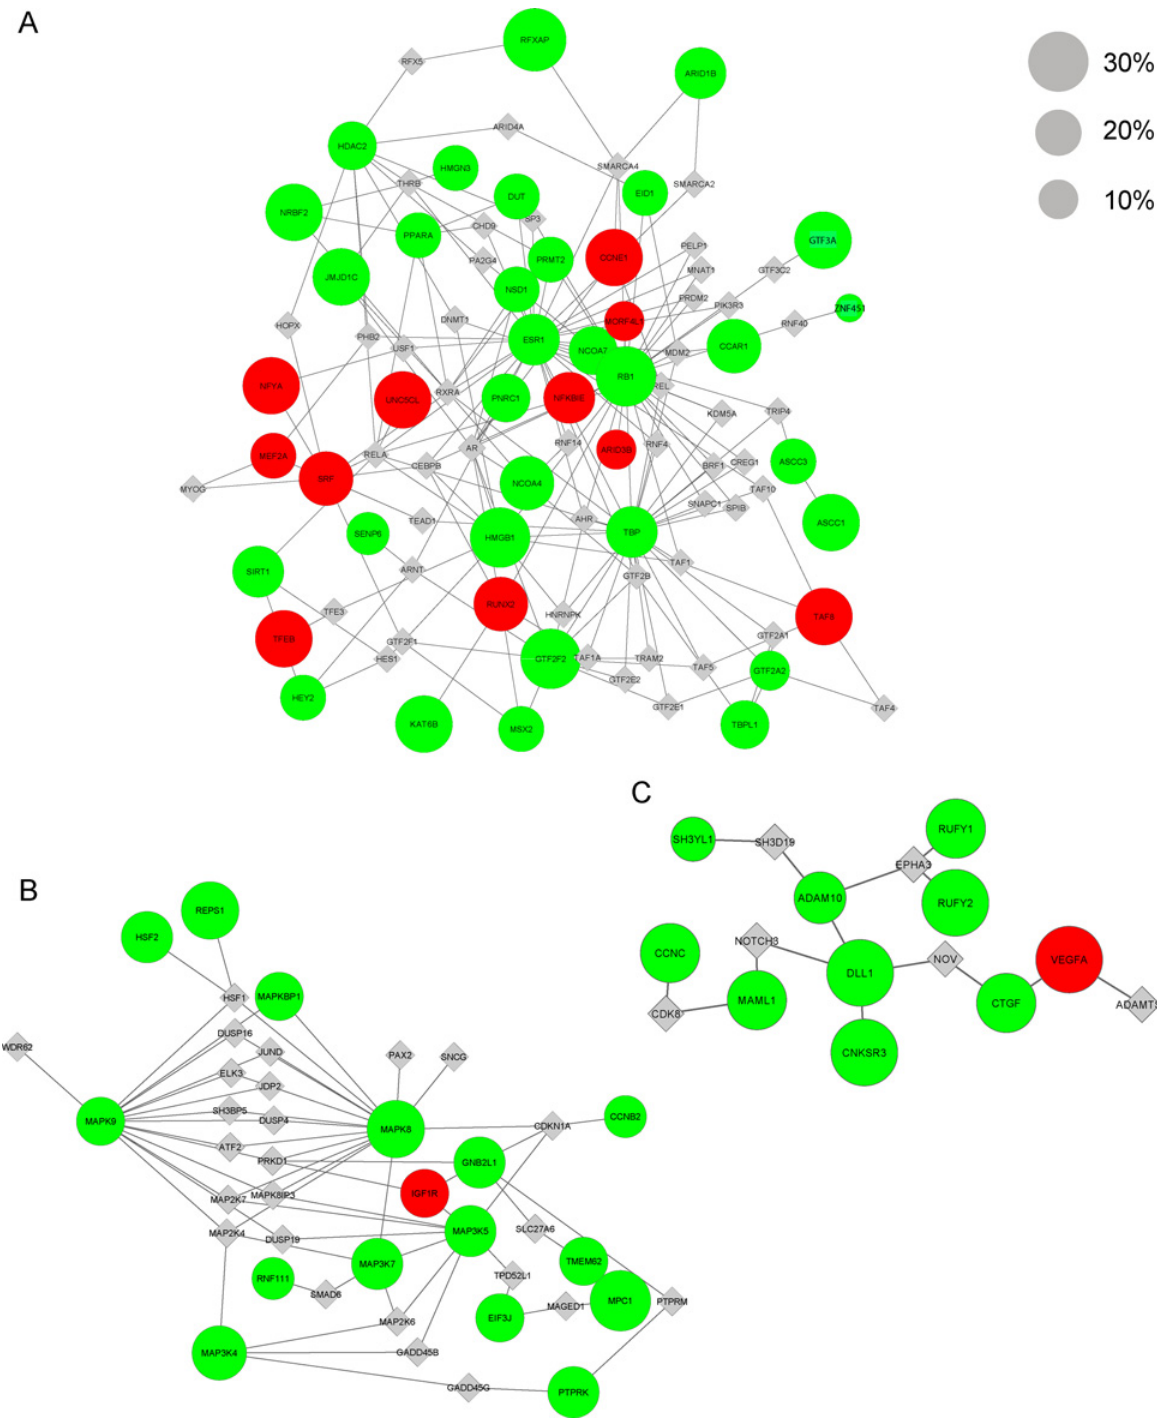
Fig 3. Selected osteosarcoma network modules. In this figures the OS network modules are illustrated for (A) the proliferation module 3, (B) the MAPK signaling module 1, and (C) the NOTCH signaling module 7. They are shown as graphs with nodes and edges. Nodes correspond to genes and edges to their protein interactions derived from the HPRD. Copy number-associated genes are presented as circles and linker genes as diamonds. The size of the nodes corresponds to the percent of OS samples holding a specific copy number loss (green) or gain (red). The linker genes are not altered in OS, therefore they have one size. Cytoband information can be found in Supporting Information S3